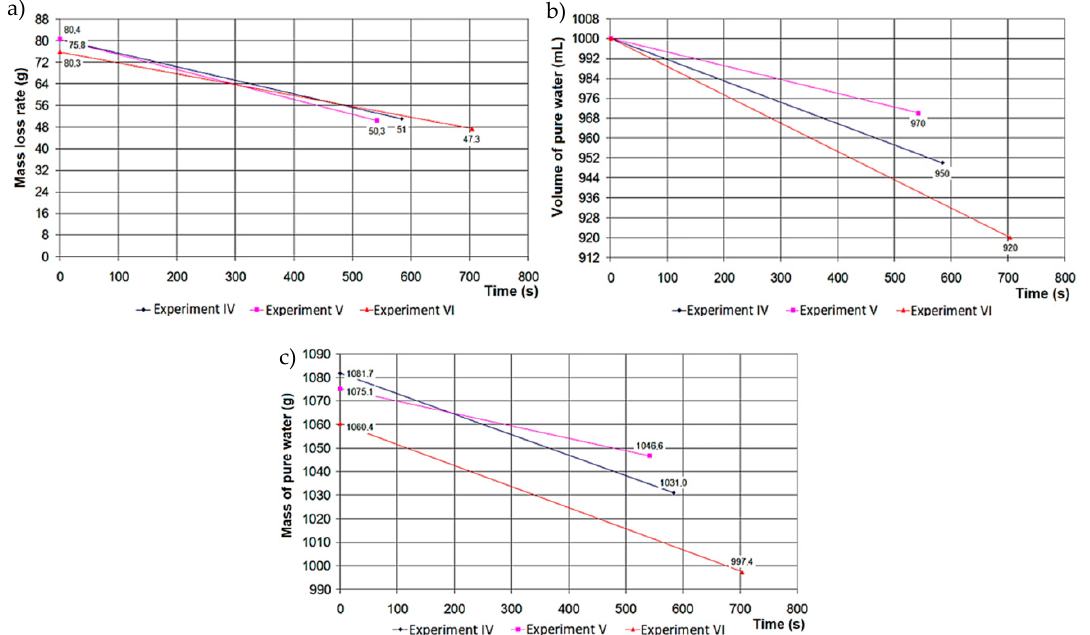
Figure 14. The changes of the mass ( c ) and volume of pure water ( b ) supplied to the gasification reactor and the mass loss rate ( a ) of the coal sample from hard coal mine B.